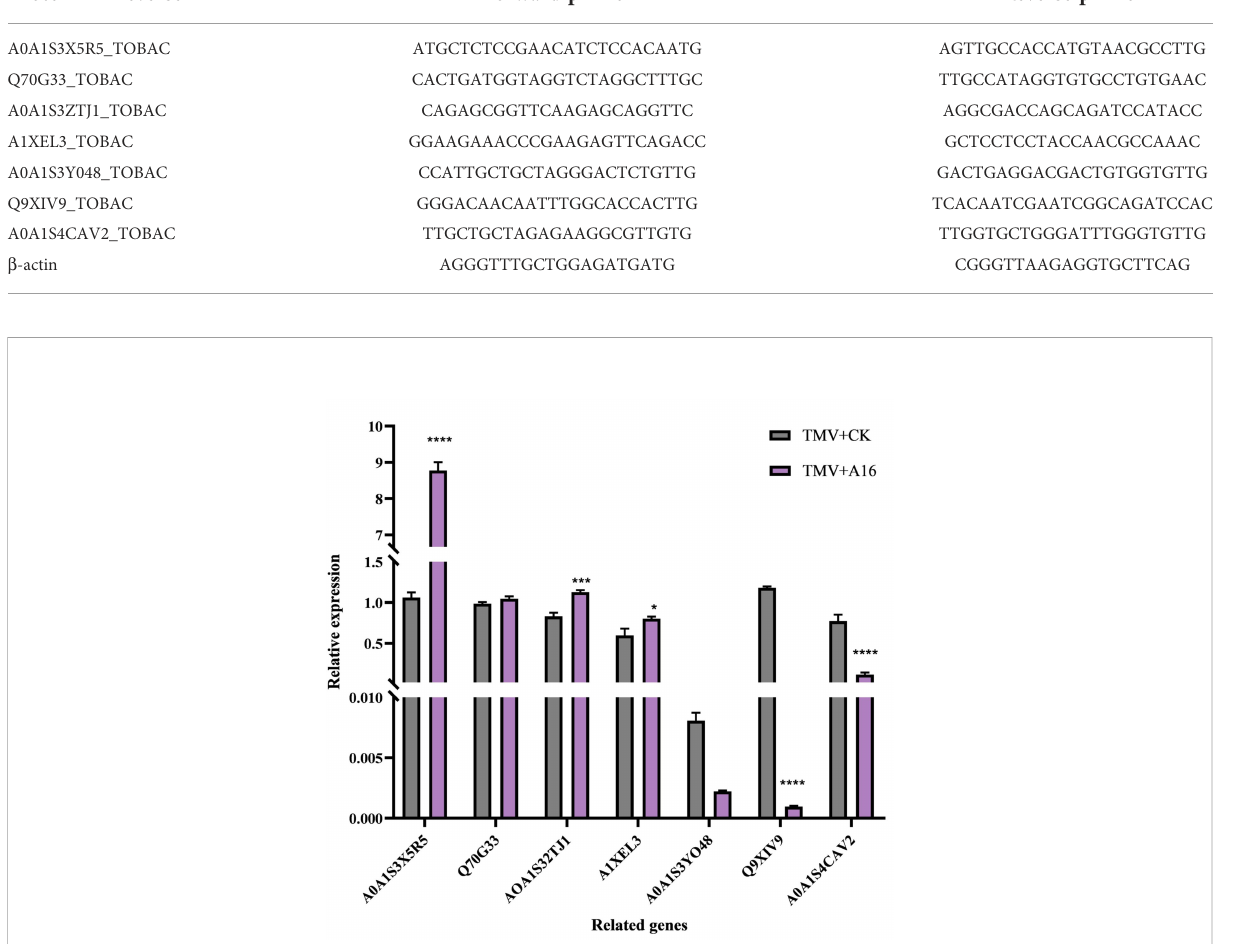
TABLE 5 Primer sequences of qRT-PCR.